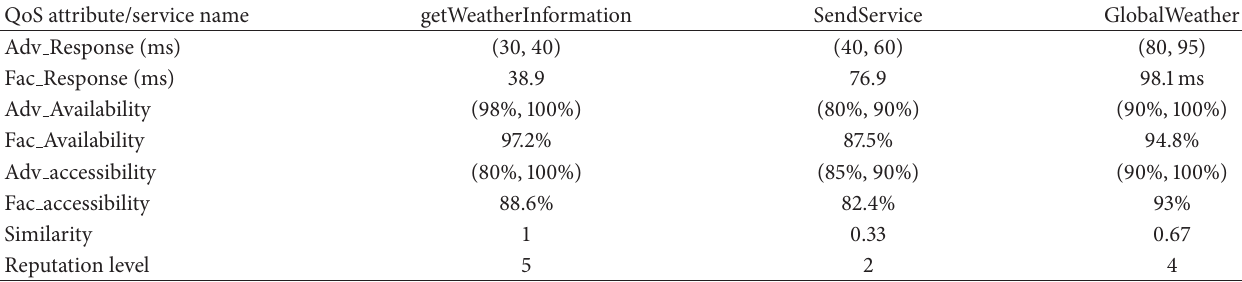
Table 1: Similarity and reputation